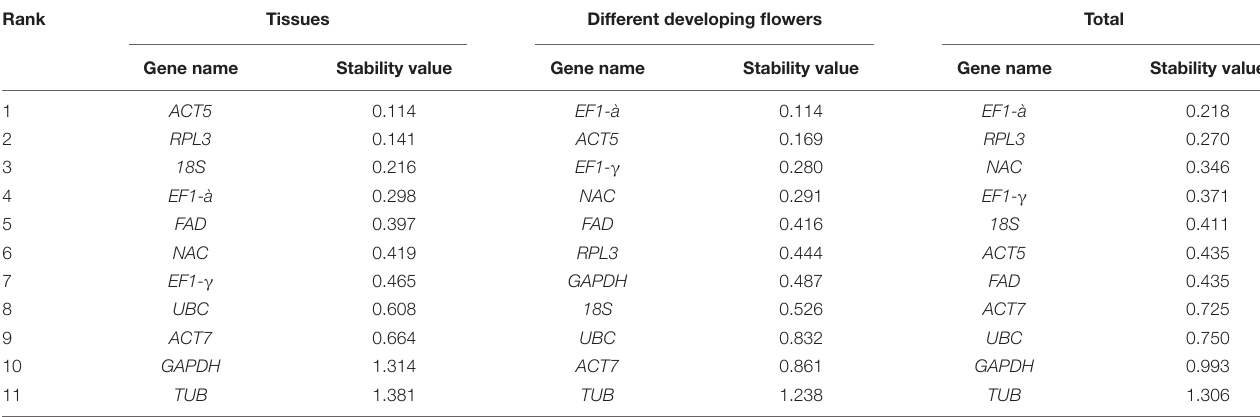
TABLE 2 | Ranking of candidate reference genes by expression stability levels determined via NormFinder.